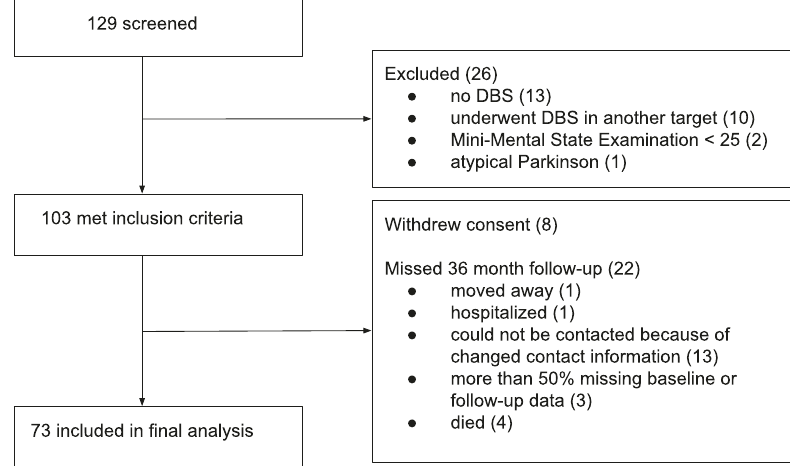
Fig. 1 Enrollment. The fl ow chart describes the enrollment of patients. DBS deep brain stimulation.